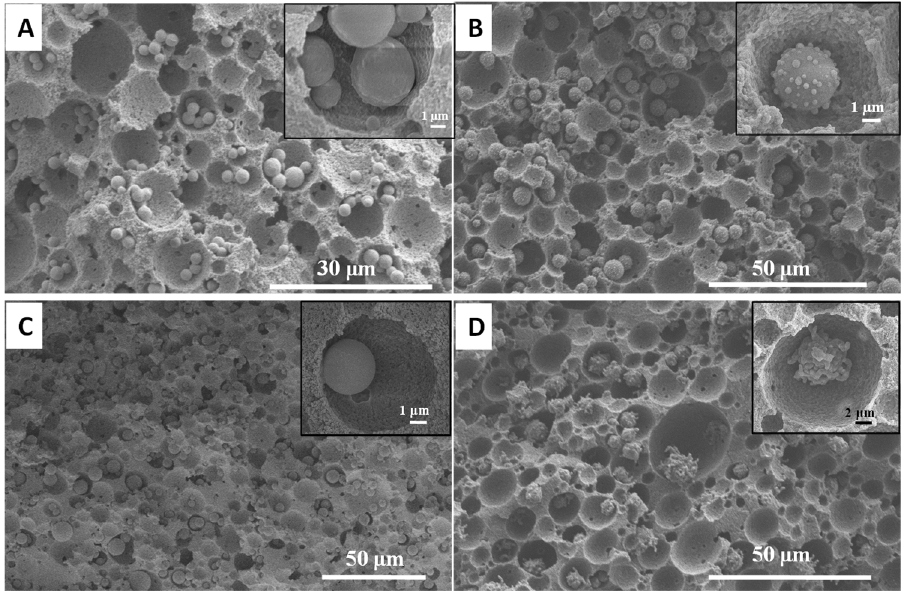
Figure 8. SEM images of the cross-sectioned silica–PAM monoliths prepared using different types of silica precursors: ( A ) VTMS, ( B ) VTMS:MPTMS (1:1), ( C ) APTES:MPTMS (1:1) and ( D ) GPTMS:MPTMS (1:1). The inset in each image shows the enlarged view of silica microspheres within an emulsion-templated